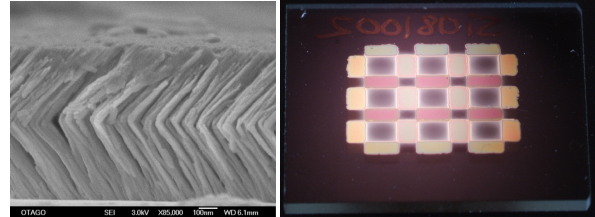
Fig. 11. (Left) An example of tilted anisotropic columns [73], with an abrupt change in orientation achieved through substrate rotation during deposition. (Right) An example of view-angle dependence in columnar films (photo by MD Arnold): the red horizontal rectangles and the olive vertical rectangles have the same optical thickness but different biaxial orientation. This patterning of angular depen- dence can easily be applied at large and small scales [14].